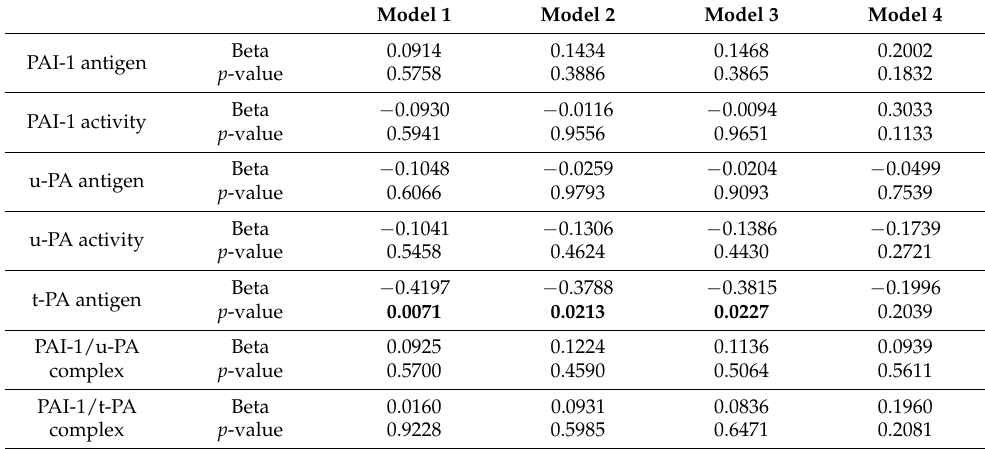
Table 8. Linear regression models for disease-free survival predictors in breast cancer